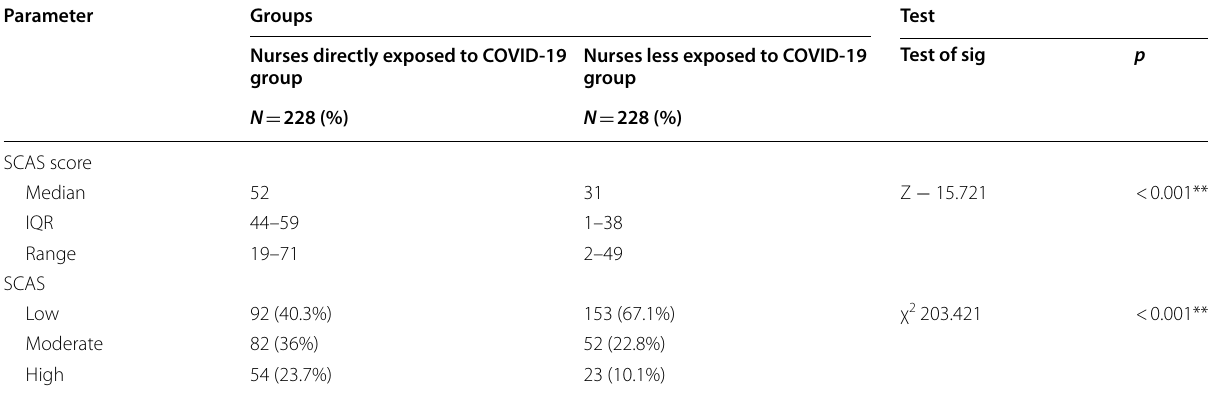
Table 2 Comparison between the studied groups regarding Specific COVID-19 Associated Stressors (SCAS)questionnaire